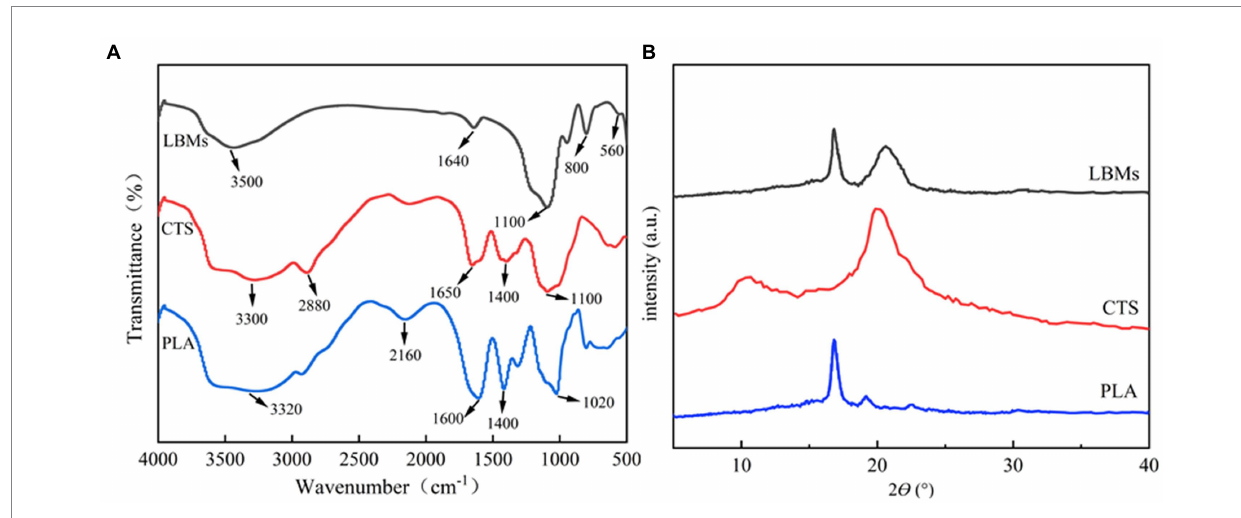
FIGURE 2 The FT-IR spectra of CTS, PLA, and LBL microcapsules (A) and XRD patterns of CTS, PLA, and LBL microcapsules (B)